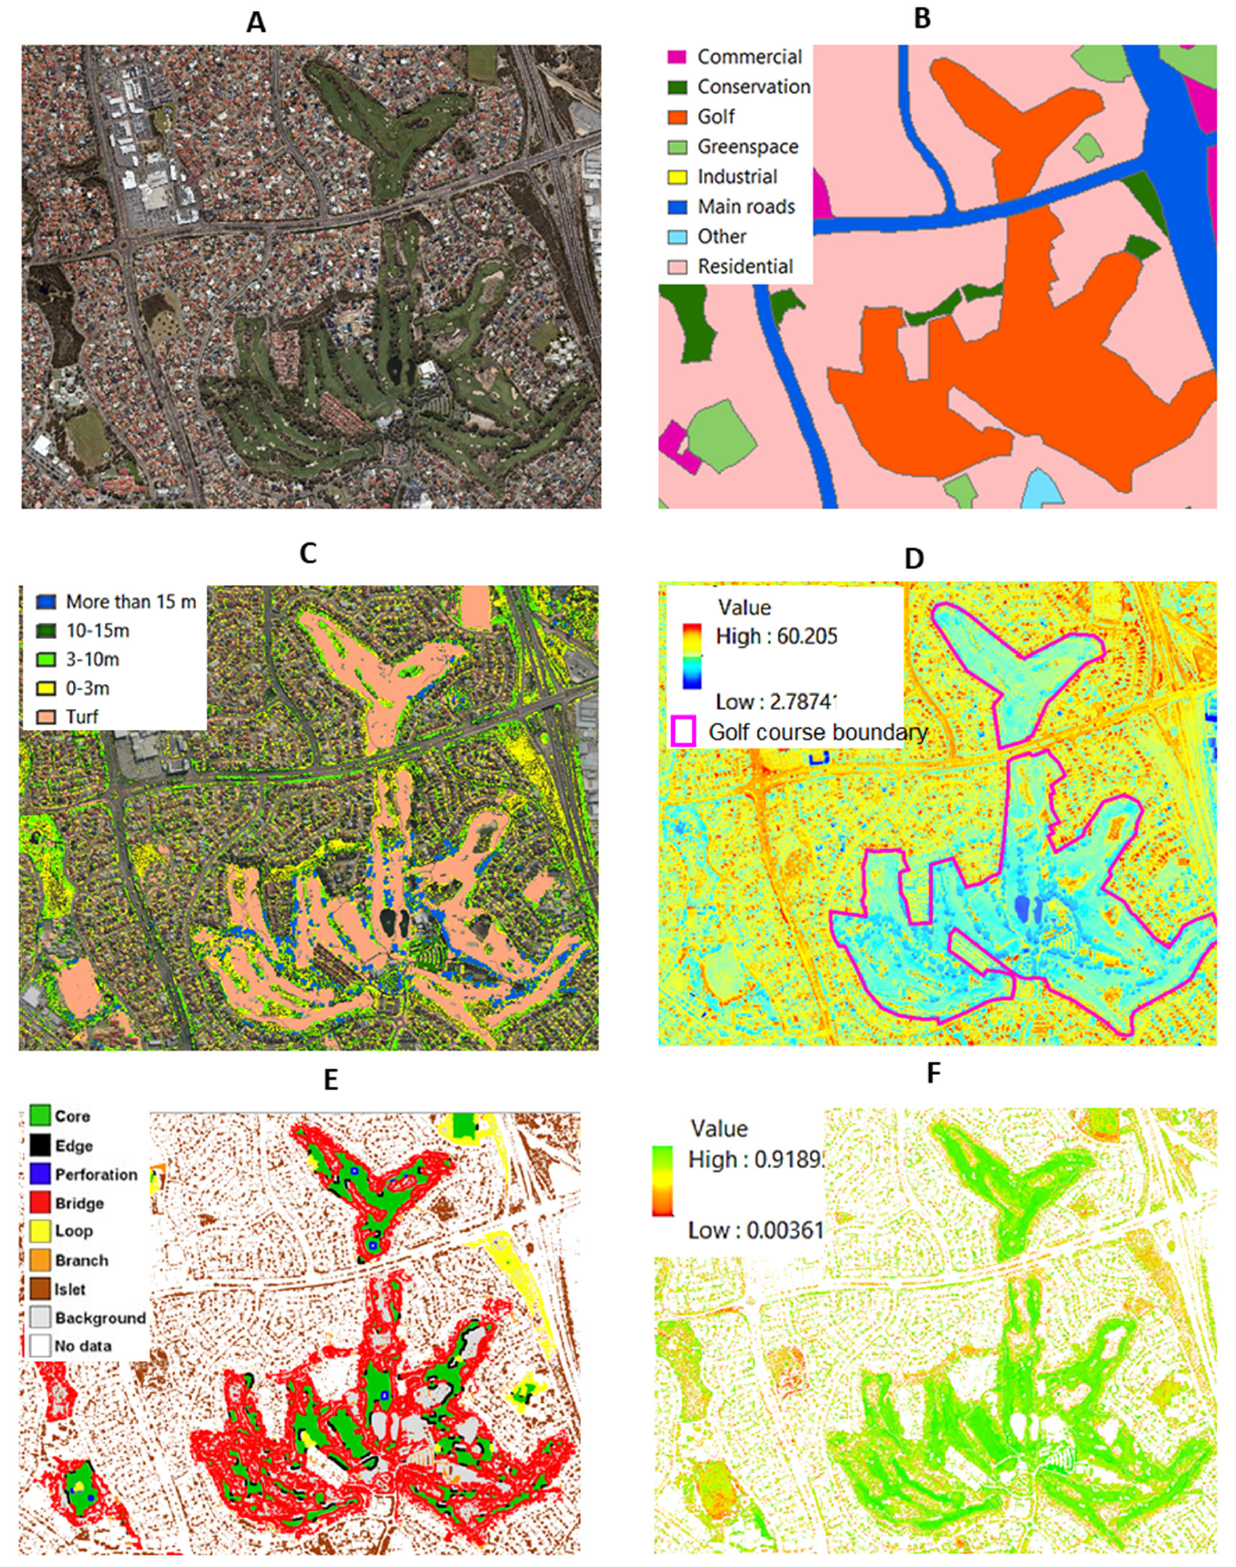
Figure 4. Joondalup Resort Golf Club and surrounds: ( A ) True color orthomosaic; ( B ) Land-use categories; ( C ) Vegetation height-strata; ( D ) Day time LST; ( E ) MSPA classes; ( F ) NDVI map. Data were collected in late summer (maximum temperature 35.1 °C) on 10 and 11 March 2020.